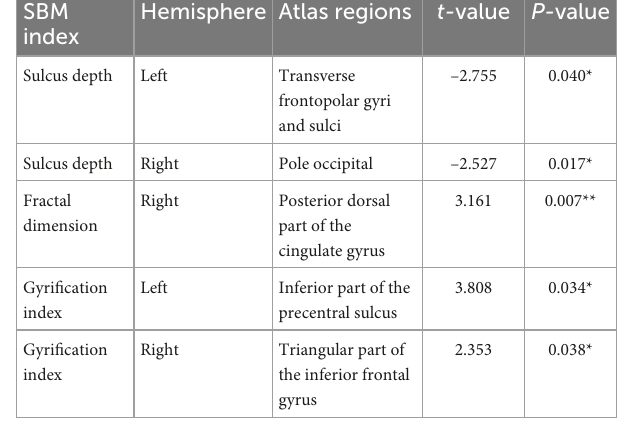
TABLE 2 Information of the differential brain regions in the SBM indices between T2DM patients with normal cognitive function and healthy